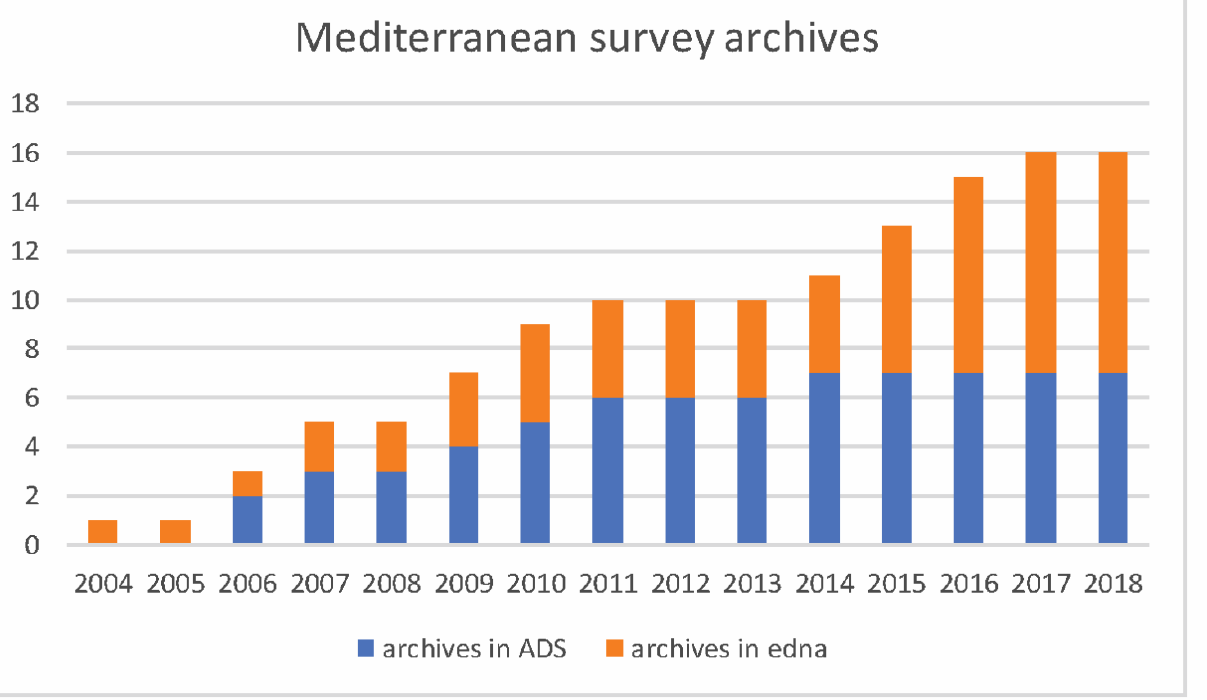
Fig. 2. Cumulative numbers of deposited Mediterranean survey archives at ADS and DANS-EDNA,